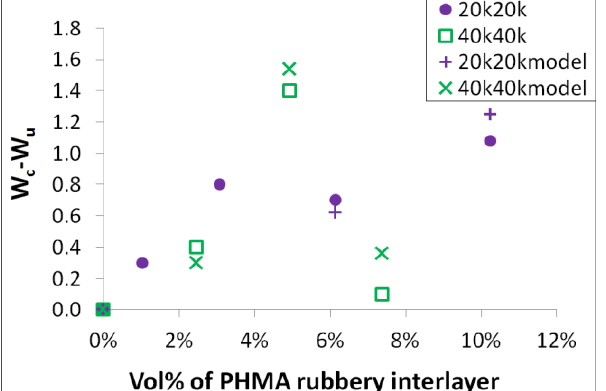
Figure 18. Plastic void growth mechanism in rubbery interlayer grafted SiO